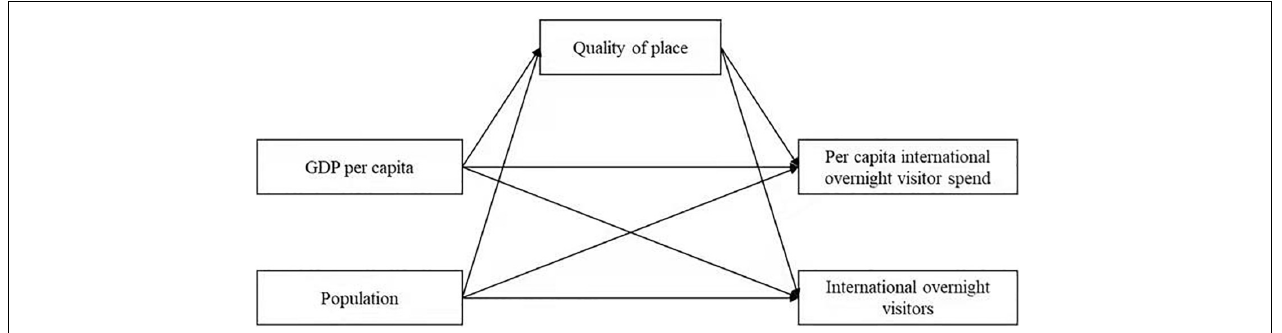
FIGURE 1 | “Local demand-quality of place-urban tourism” mediation